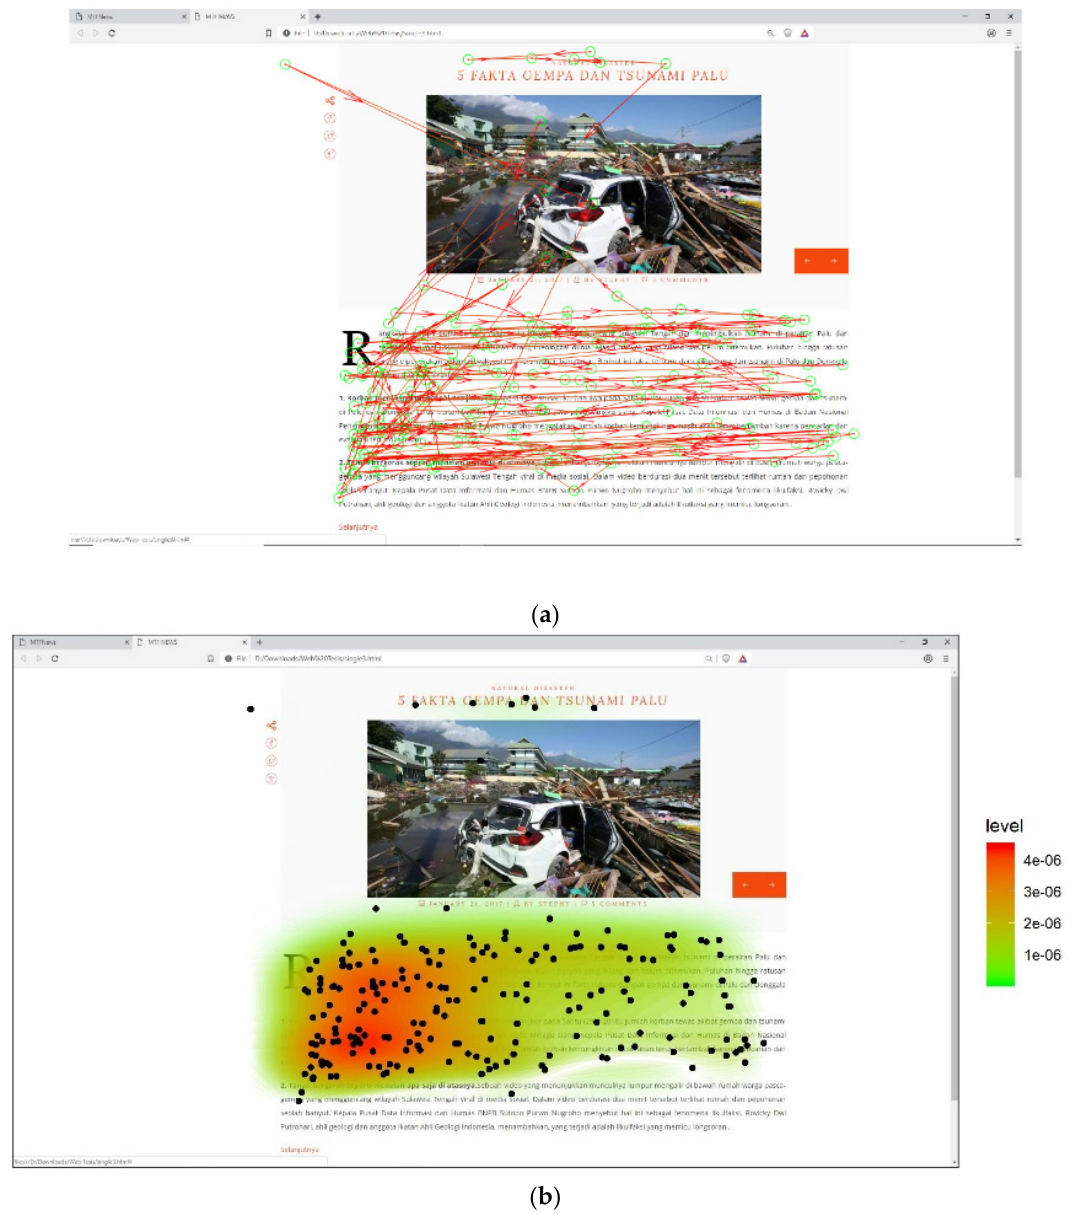
Figure 7. (a). Example of gaze plot of severe anxiety; (b) example of heat map of severe anxiety. Figure 7. ( a ) Example of gaze plot of severe anxiety; ( b ) example of heat map of severe